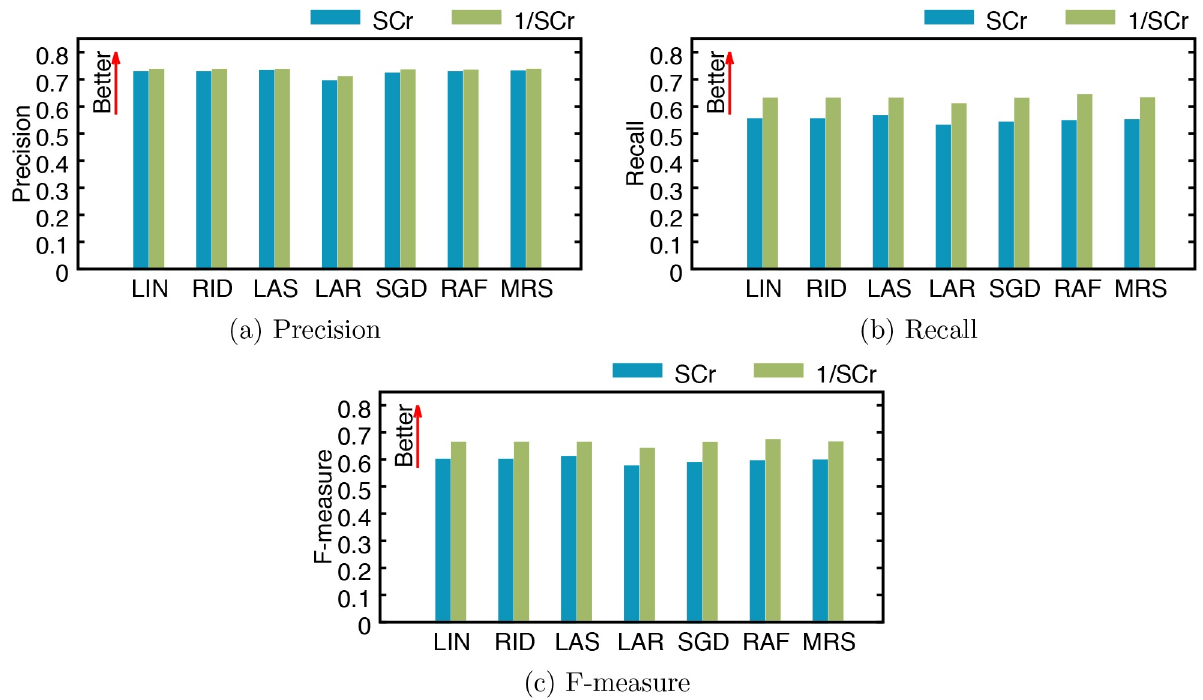
Fig 5. Performance of AKI stage classification by several models using SCr and 1/SCr. (a) precision, (b) recall, and (c) F-measure. LIN: linear regression, RID: ridge regression, LAS: lasso, LAR: least-angle regression (LARS), SGD: stochastic gradient descent, RAF: random forest, and MRS: multivariate adaptive regression splines